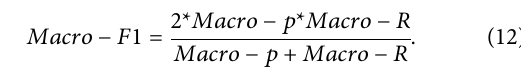
Frontiers in Genetics |